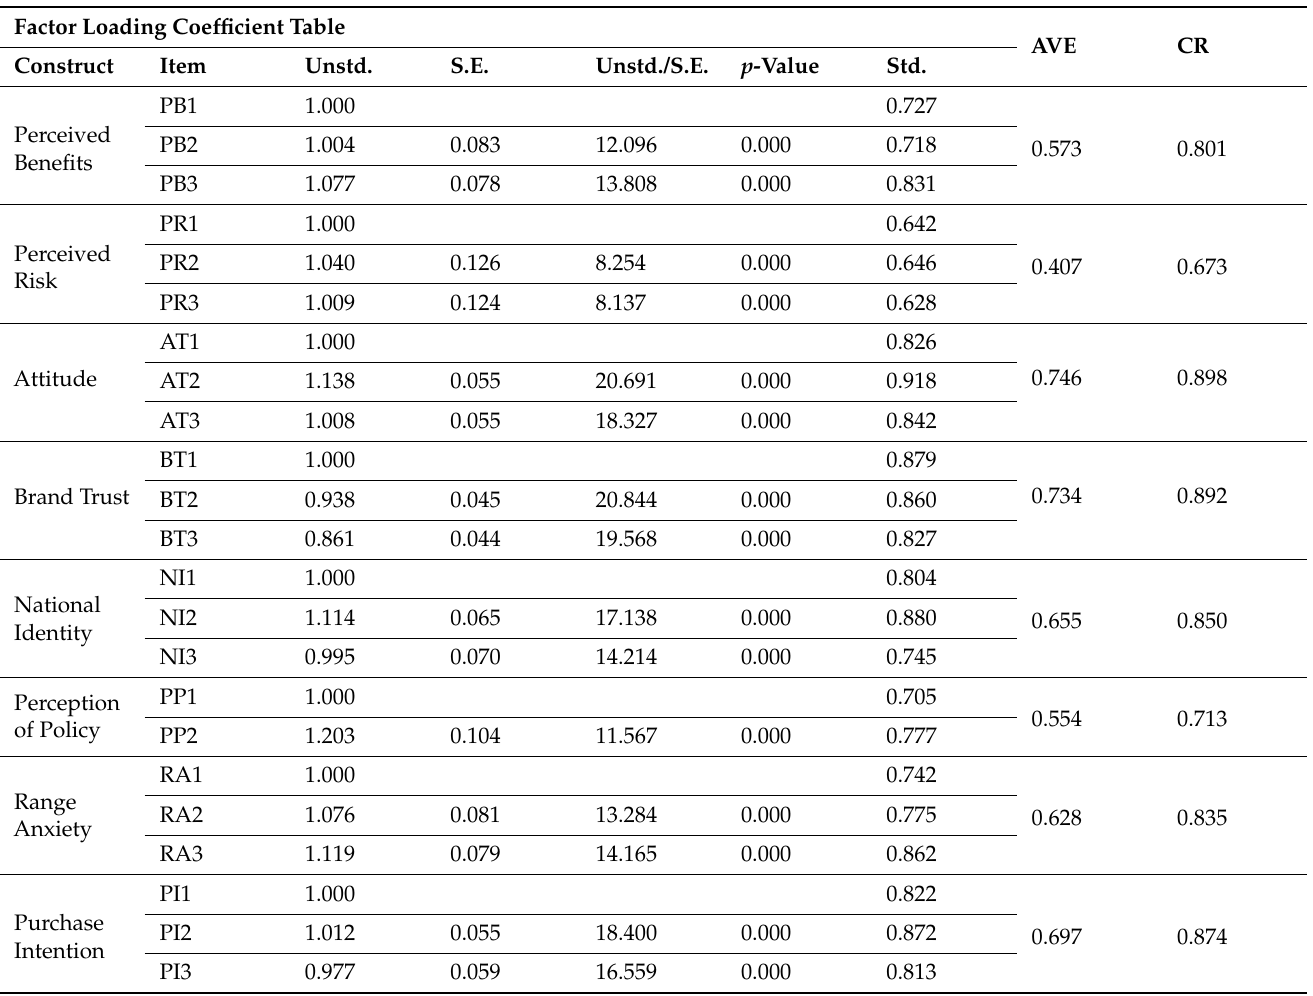
Table 5. The results of the measurement